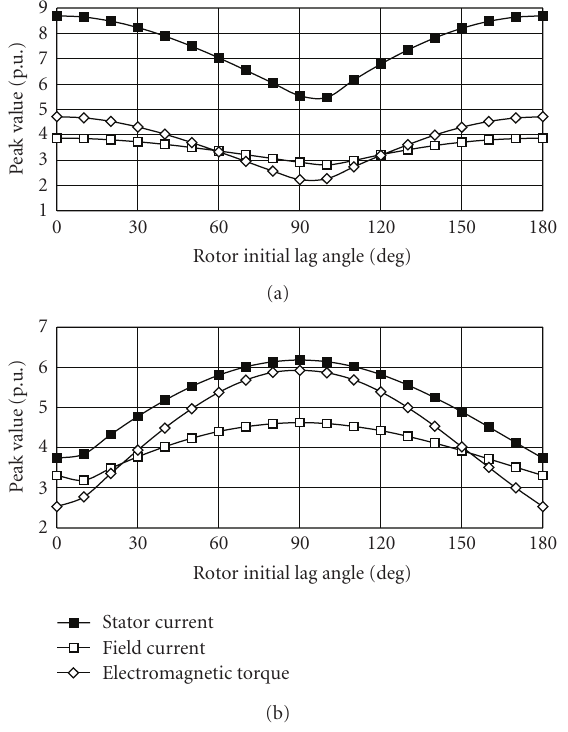
Figure 3: Time-related evolution curves of currents at line-to- ground short circuit, in the favorable circumstance: (a) stator phase A current, (b) field